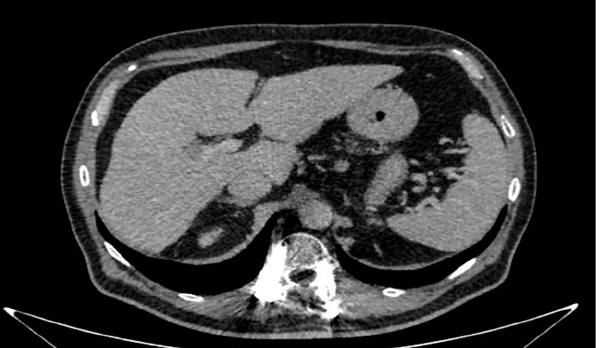
Figure 1. Conventional computed tomography revealed 17 mm × 12 mm nodular lesion in the V hepatic segment.